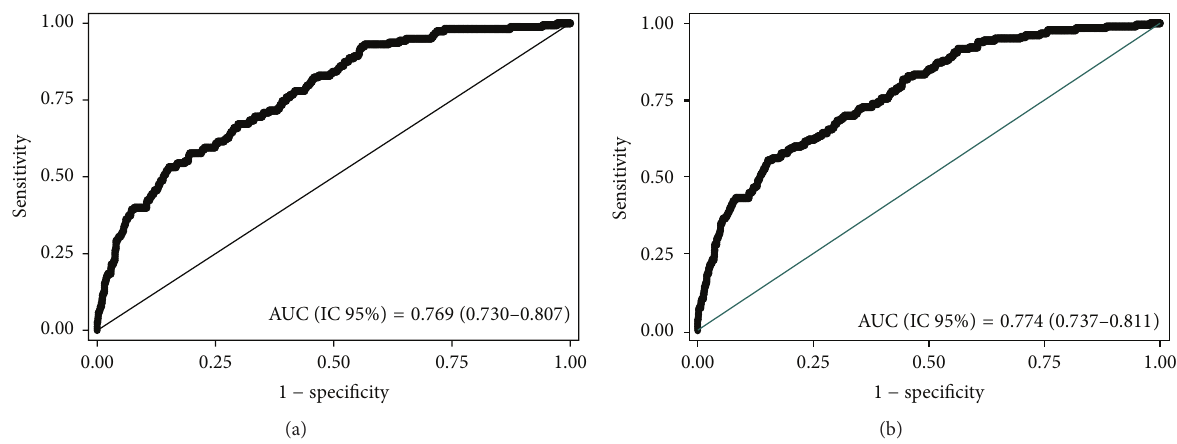
Figure 1: ROC curve derived from the logistic regression analysis of delayed graft function (DGF) with (a) (1155 grafts) and without (b) (1069 grafts) acute rejection episodes (ARE).